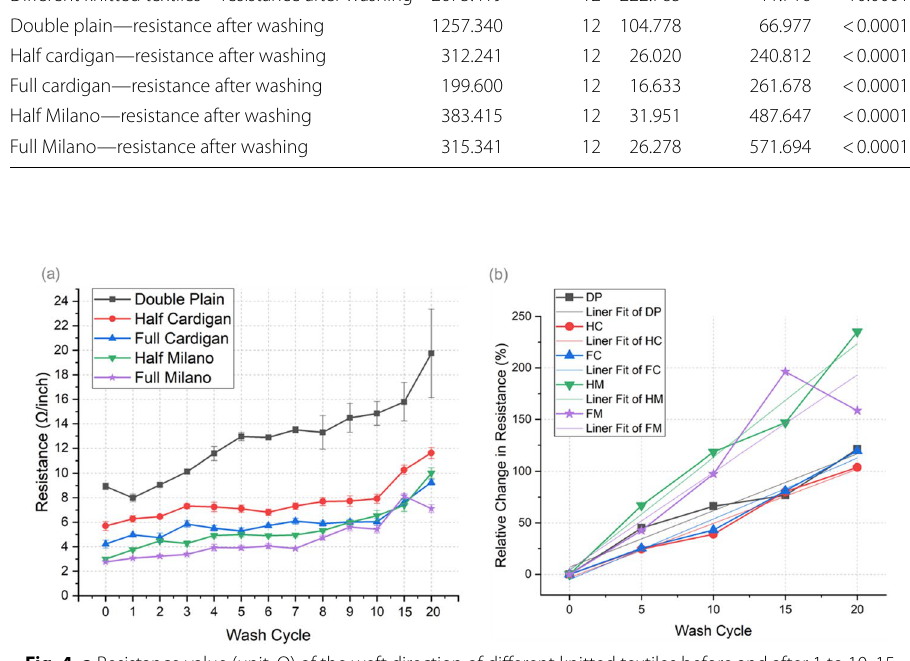
Table 4 One-way ANOVA carried out for different knitted textiles and washing Source of variance Sum of squares df Mean square F p‑value Different knitted textiles—resistance after washing 2673.419